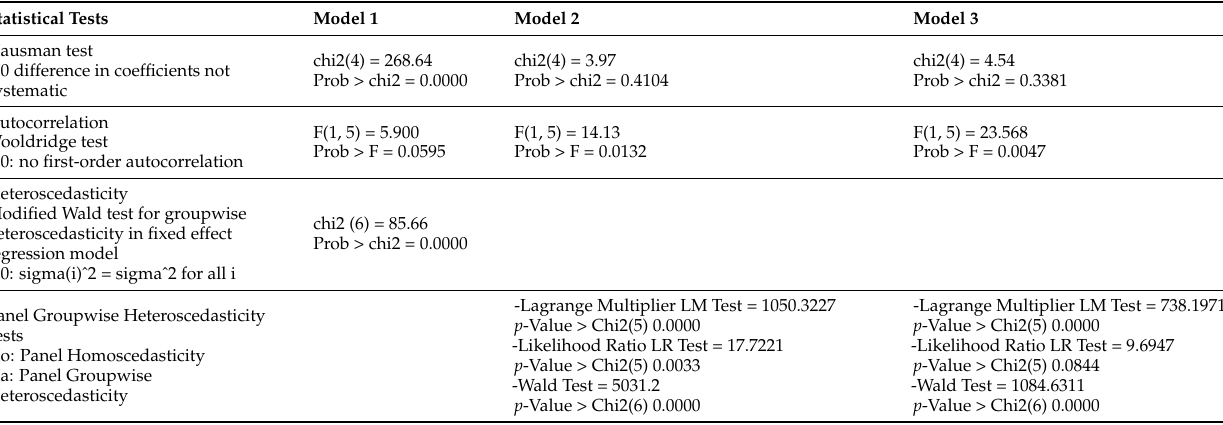
Table 3. Statistical diagnostic tests and specification of panel